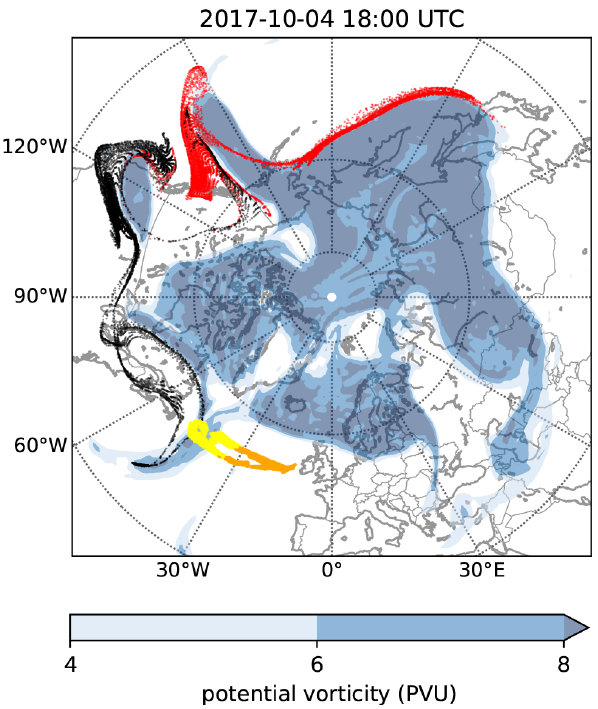
Figure 3. Air mass origin plot for the retrieved 2-D data. Horizontal cut at 11km altitude 3d before measurement flight is shown. Loca- tions of GLORIA observations on 7 October: yellow – near polar jet (west from 30 ◦ W, PV > 1PVU); orange – away from jet (all the rest). The positions of “yellow” air parcels 3d before measurement are shown in red; those of “orange” air parcels are in